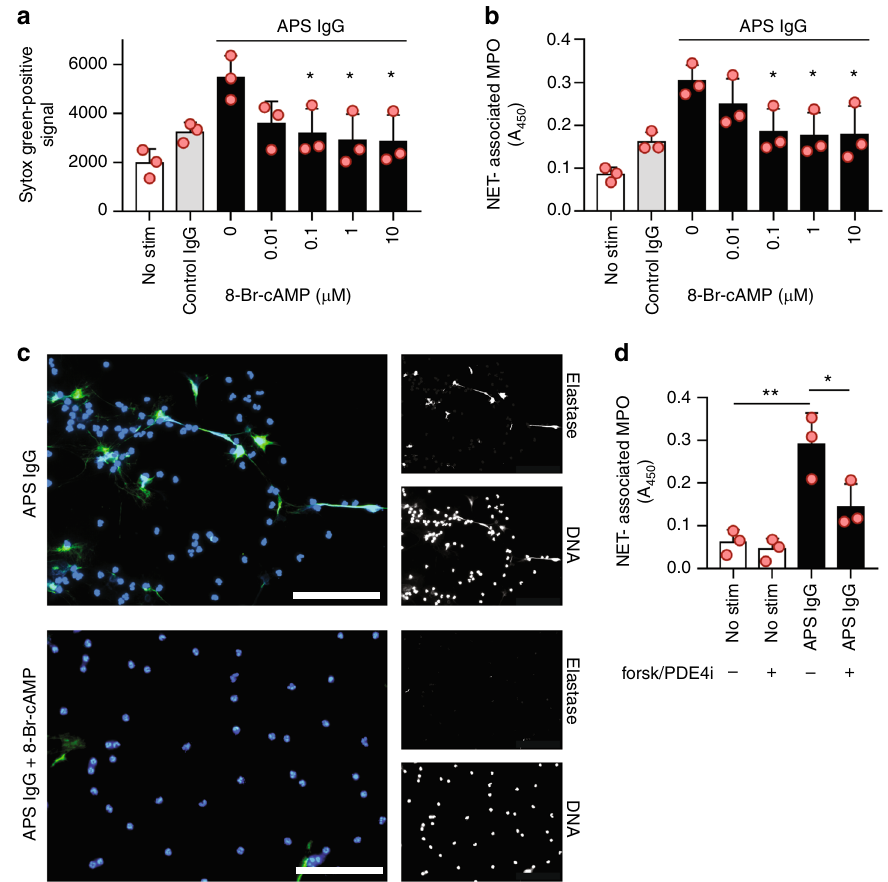
Fig. 1 Cyclic AMP (cAMP) suppresses NETosis in response to APS IgG. Neutrophils were isolated from healthy volunteers and then treated with either control IgG or APS IgG (pooled from four patients with primary APS) for 3 h. Some samples were additionally treated with 8-Br-cAMP at various concentrations. In panel a , total extracellular DNA was measured as relative fl uorescence units upon the addition of Sytox Green. In panel b , an independent set of experiments was performed, with NETosis quanti fi ed by measuring the enzymatic activity of nuclease-liberated myeloperoxidase (MPO). Mean and standard deviation are presented for n = 3 independent experiments; * p < 0.05 as compared with the 0 µ M group by one-way ANOVA corrected with Dunnett ’ s test. c NETosis was assessed qualitatively by immuno fl uorescence microscopy. 8-Br-cAMP = 1 µ M, blue = DNA, green = extracellular neutrophil elastase, and scale bar = 100 microns. d Neutrophils were treated with either control IgG or APS IgG. Forskolin and PDE4 inhibitor were additionally added to some samples. NETosis was quanti fi ed by the enzymatic activity of nuclease-liberated MPO; * p < 0.05 and ** p < 0.01 by one-way ANOVA corrected with Sidak ’ s